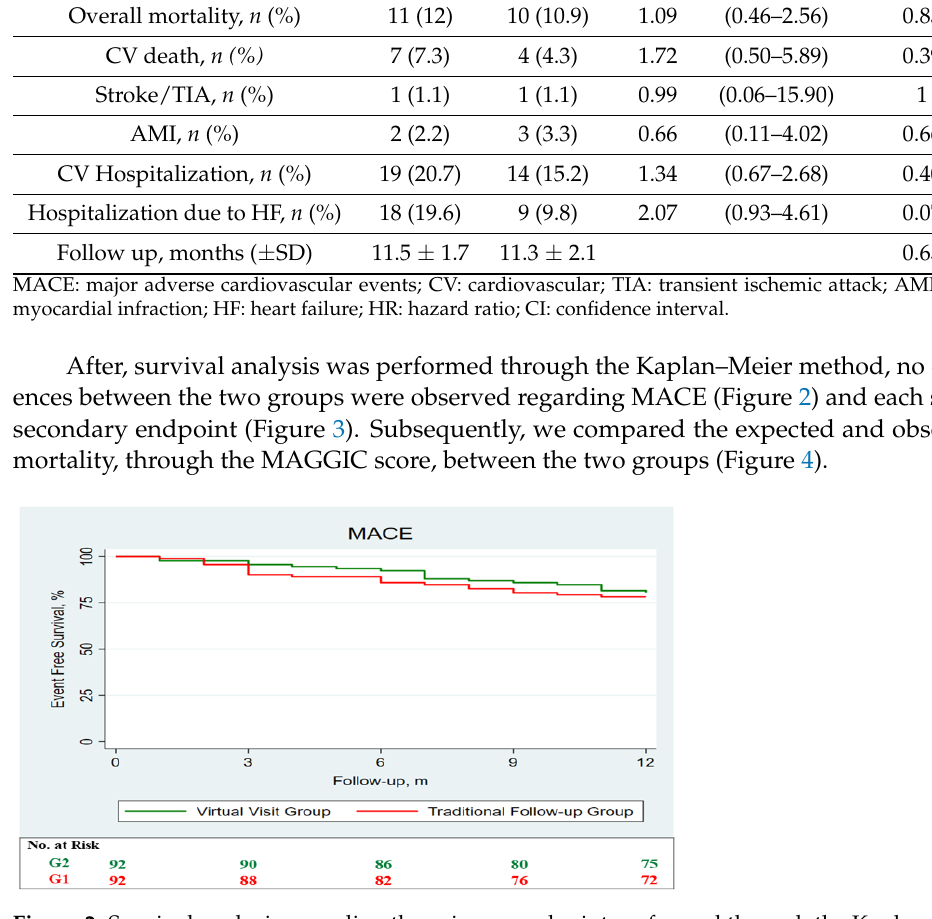
Table 3. Adverse cardiovascular events during the follow up period.